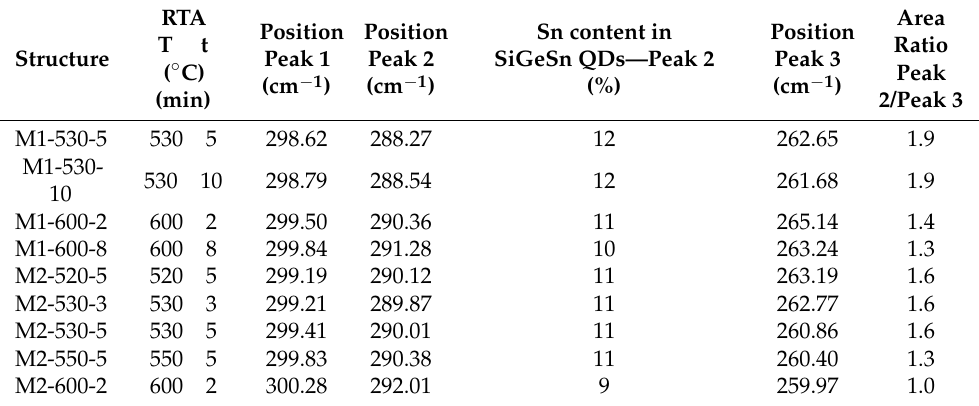
Figure 3. Raman spectra: ( a , b ) as-deposited and RTA samples M1 and M2, respectively; ( c , d ) nor- malized spectra of annealed structures M1 and M2, respectively plotted in the 270–310 cm –1 region corresponding to Ge-Ge mode in SiGeSn NCs. 550, and 600 °C), we obtain the results from Table 1. Table 1. Deconvolution results of 3 Gauss peaks of Raman spectra: peak positions, area ratio of Peak 2 to Peak 3, and Sn content in the SiGeSn QDs with high Sn content (Peak 2).